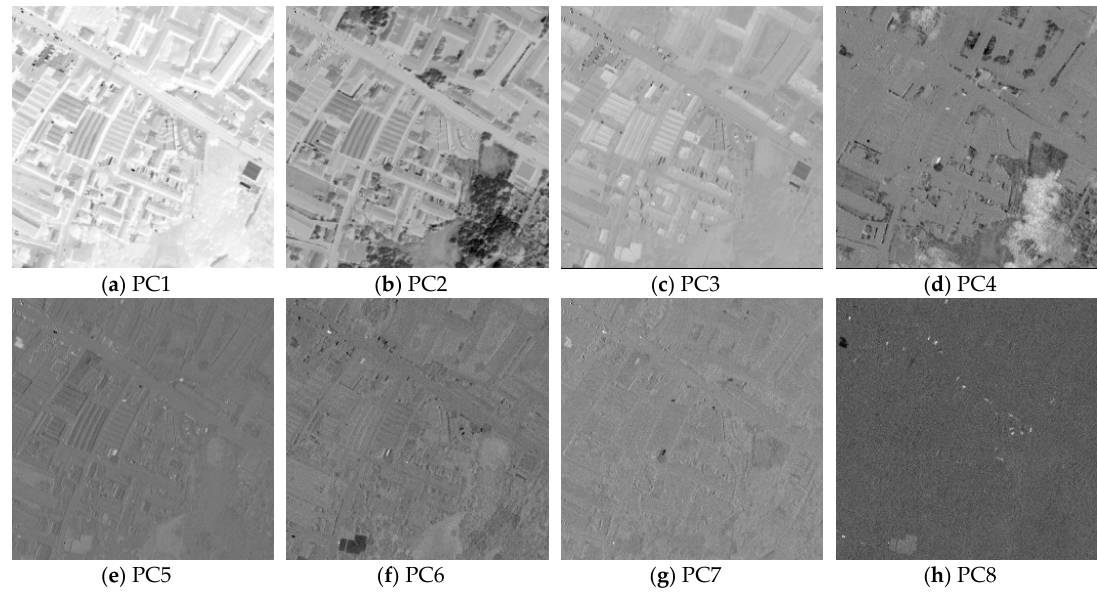
Figure 2. The top eight PCs obtained by MNF.